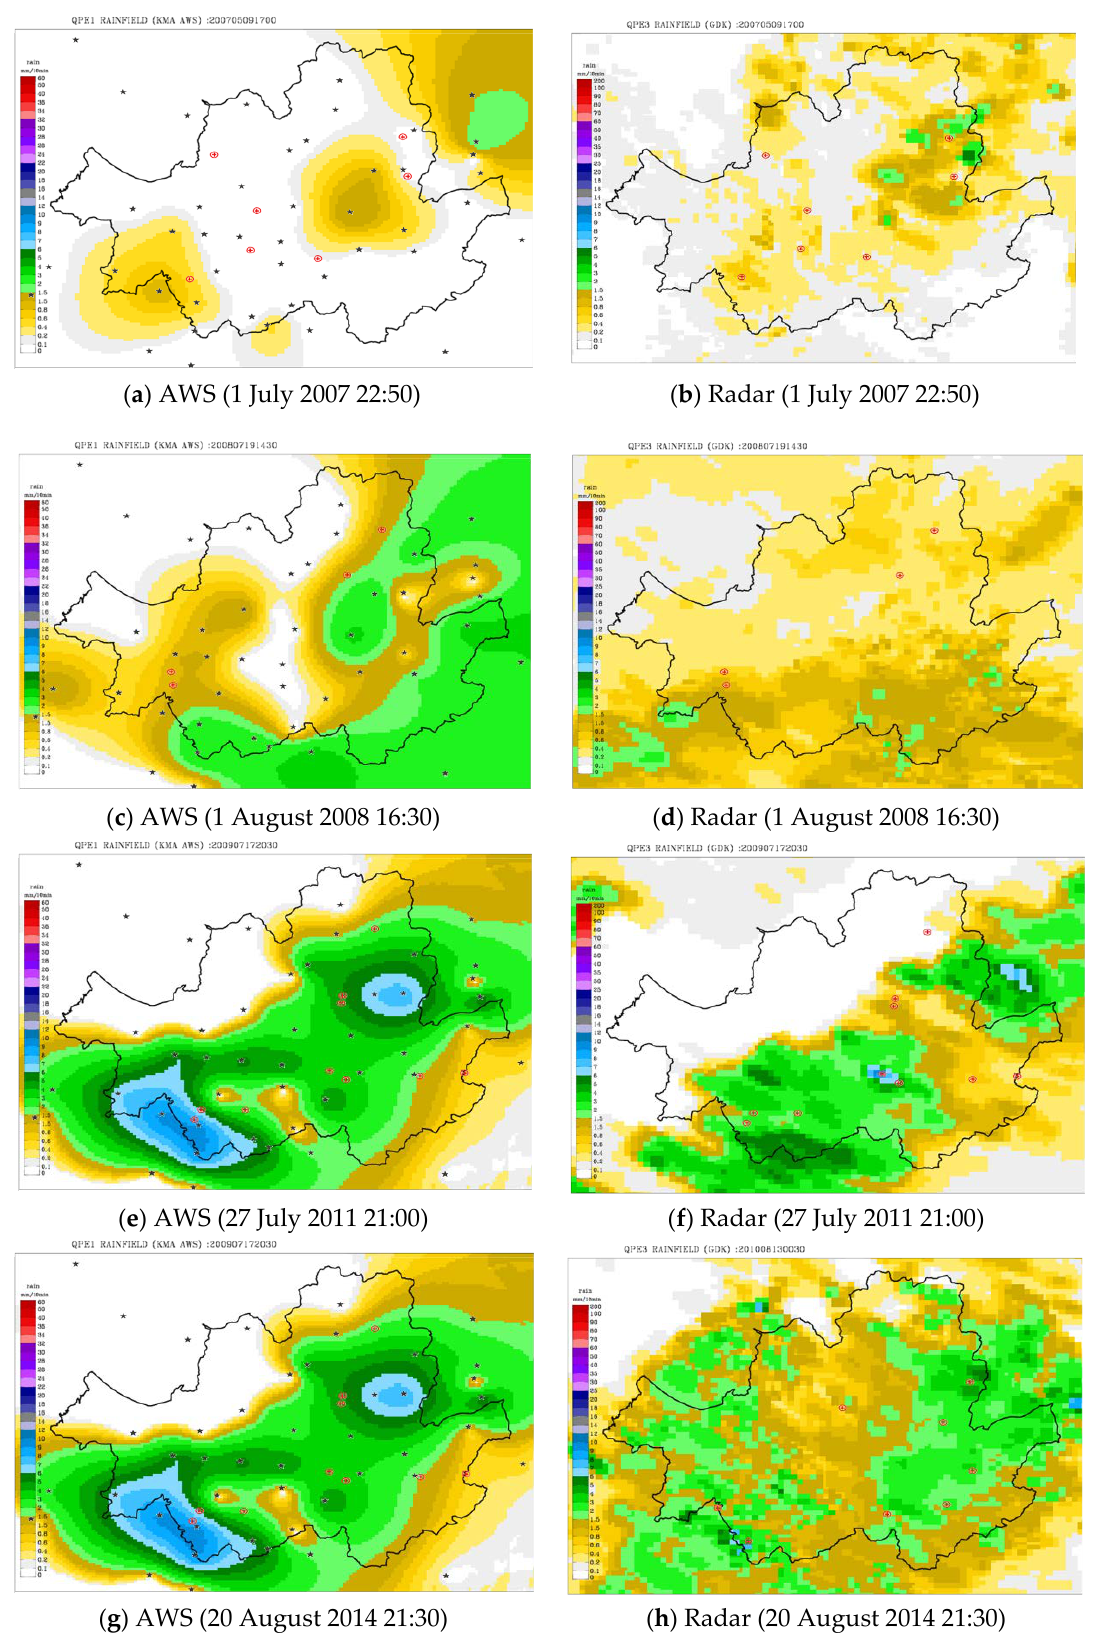
Figure 6. Comparison of interpolated AWS (left column) and radar-derived (right column) rainfall distribution with traffic accident locations (red circles) for stratiform rain events.